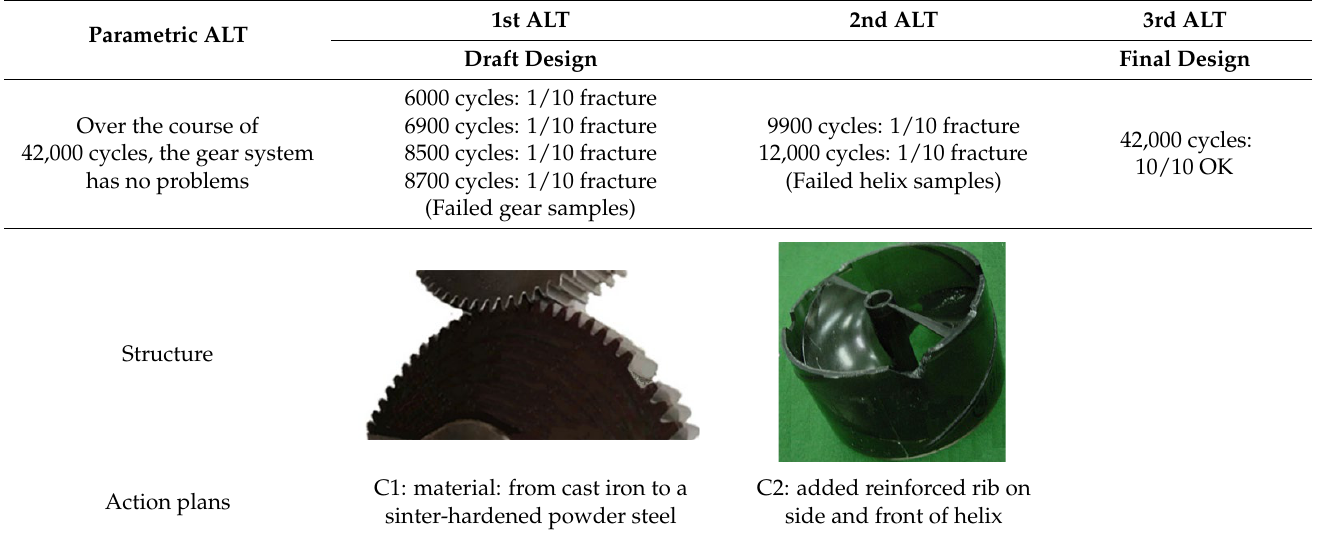
Table 3. ALT outcomes for ice-maker including auger motor with gear system.